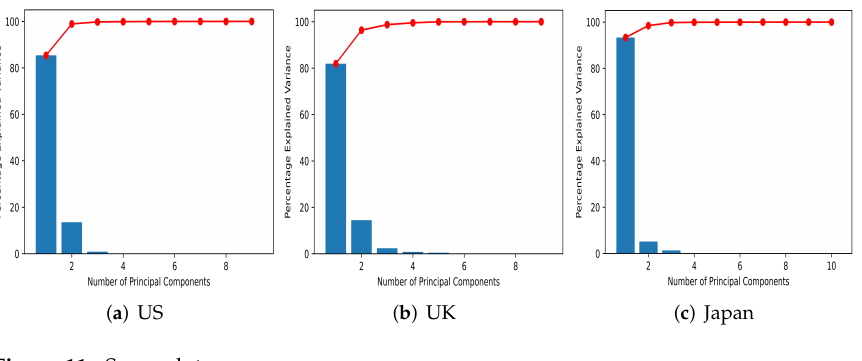
Figure 11. Scree plots.